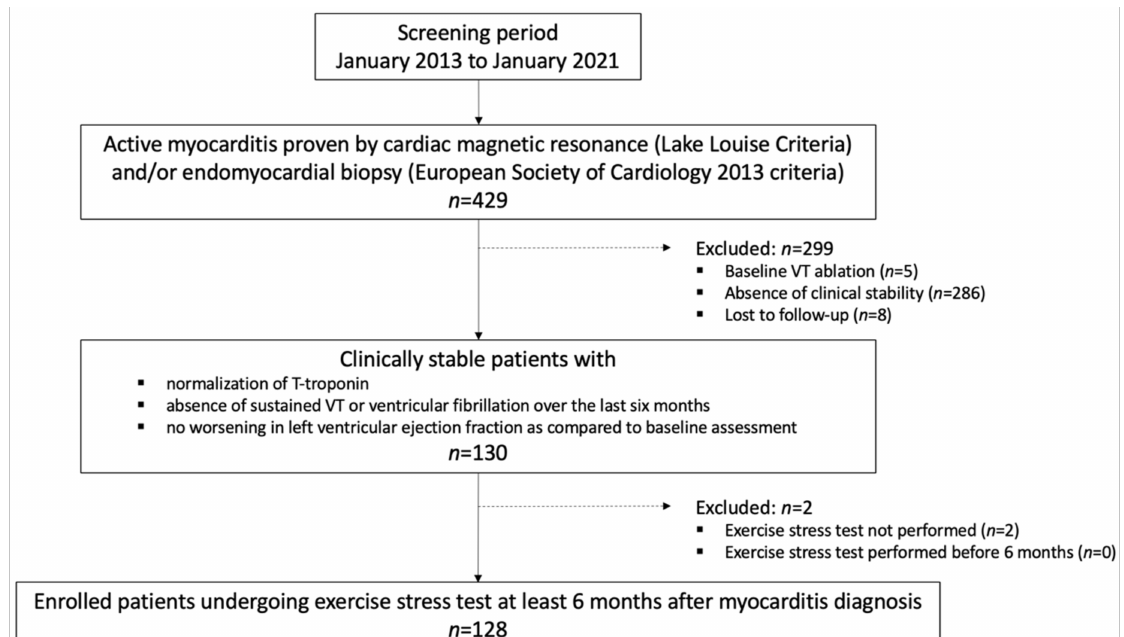
Figure 1. Patient selection. The study flowchart is shown to highlight the selection of the 128 patients undergoing an exercise stress test. VT = ventricular